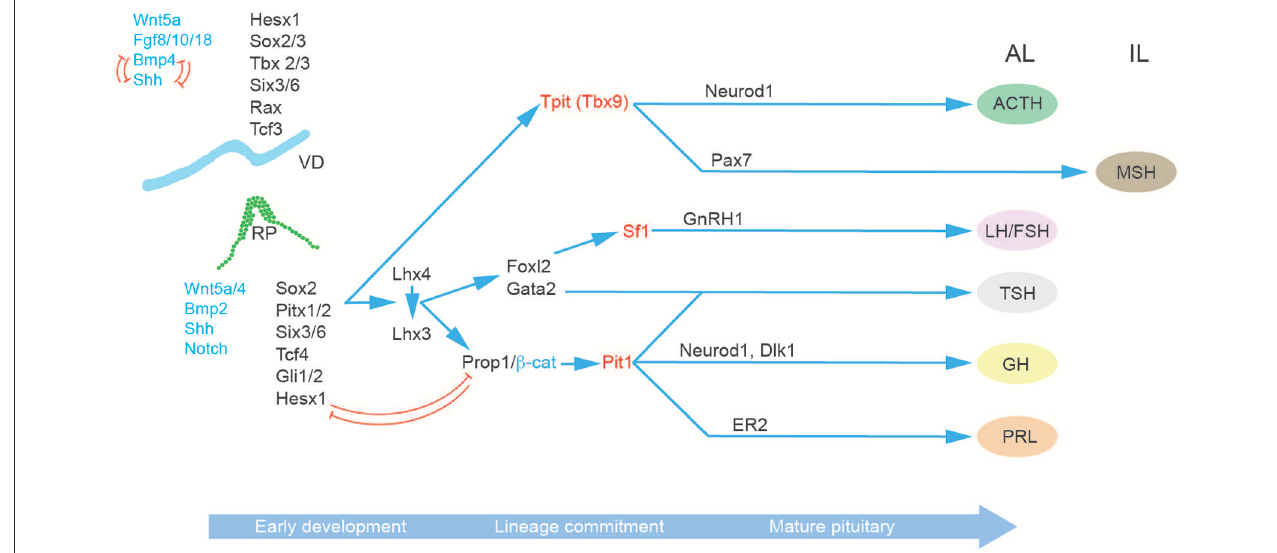
FIGURE 2 | Molecular regulation of pituitary gland development. A succession of transcription factors (black) and signaling molecules (blue) determine the establishment of RP and the subsequent lineage specification and differentiation in the progenitor cells of the developing pituitary hormone-secreting cell types characteristic of the mature anterior pituitary gland: corticotrophs (ACTH), gonadotrophs (FSH and LH), thyrotrophs (TSH), somatotrophs (GH), and lactotrophs (PRL). The key lineage commitment makers are highlighted in red. Arrows indicate upstream relationships in molecular signaling pathways, not necessarily direct activation. Red T-bar arrows denote repressive relationships. Abbreviations: ACTH, adrenocorticotropic hormone; AL, anterior lobe; FSH, follicle-stimulating hormone; GH, growth hormone; IL, intermediate lobe; LH, luteinizing hormone; MZ, marginal zone; PL, posterior lobe; PRL, prolactin; RP, Rathke’s pouch, VD; Ventral